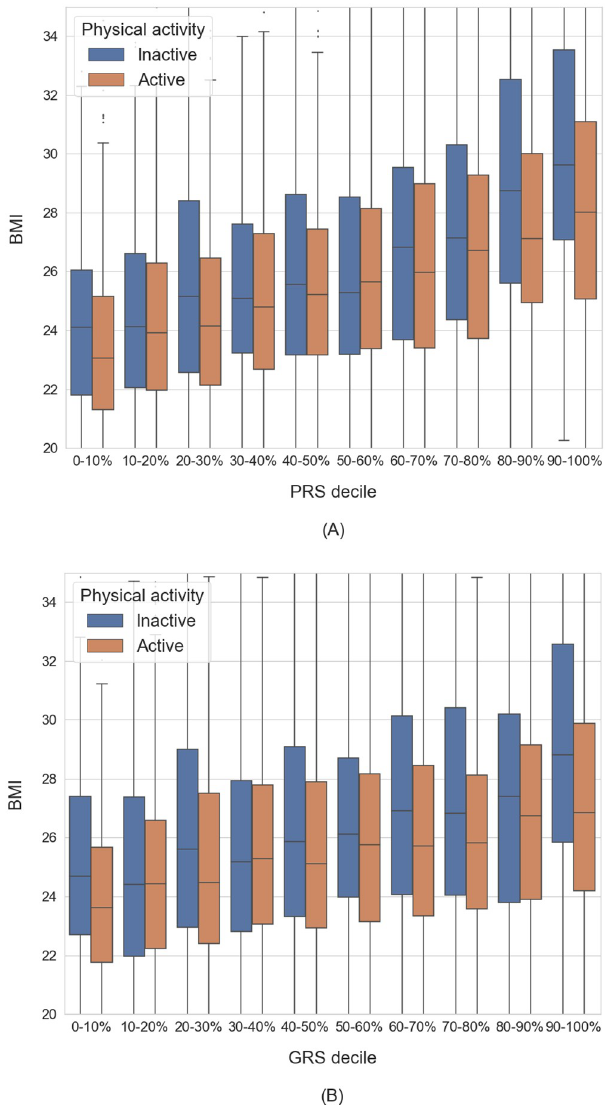
Fig 3. BMI distribution of individuals, stratified by genetic risk and levels of physical activity. (A): Individuals stratified by BMI PRS deciles. (B): Individuals stratified by BMI GRS deciles. Both graphs are plotted in the same scale and cut at 10 th / 90 th percentiles on the y-axis. Box plots represent the median and 25 th / 75 th percentiles. Whiskers are set at 1.5 IQR. Both graphs show BMI, unadjusted for age and sex. Adjusted BMI residuals and outliers are available at Online